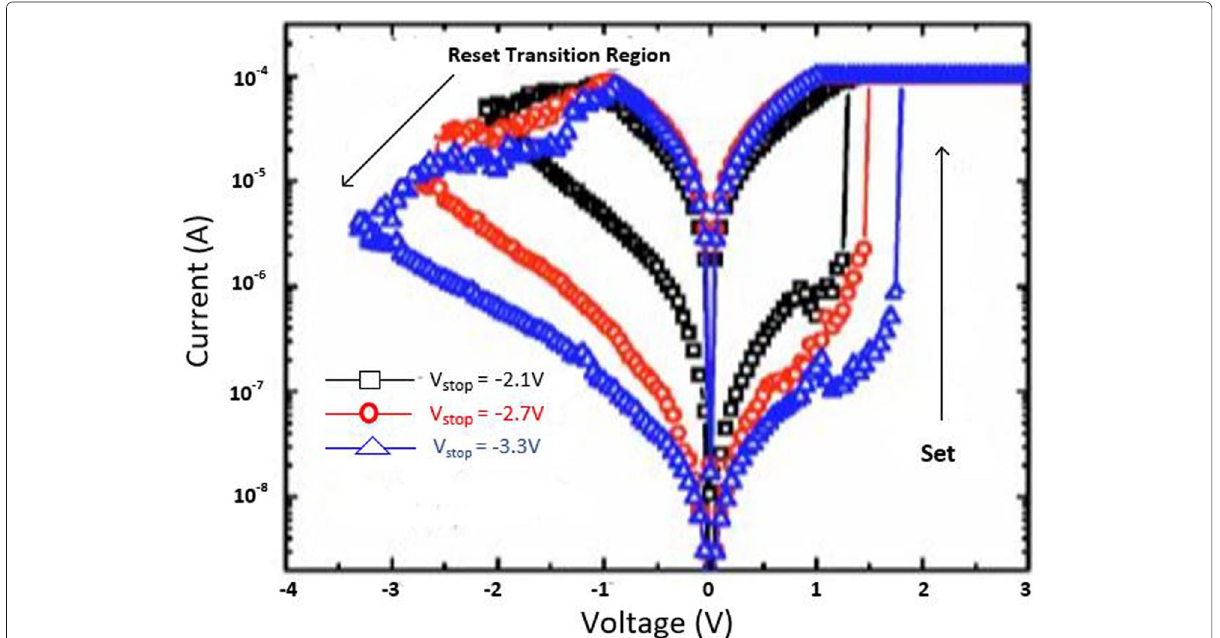
Fig. 13 Multilevel characteristics of TiN/HfO x /AlO x /Pt RRAM obtained by controlling the reset voltage. ‘Reproduced from [128], with the permission of AIP